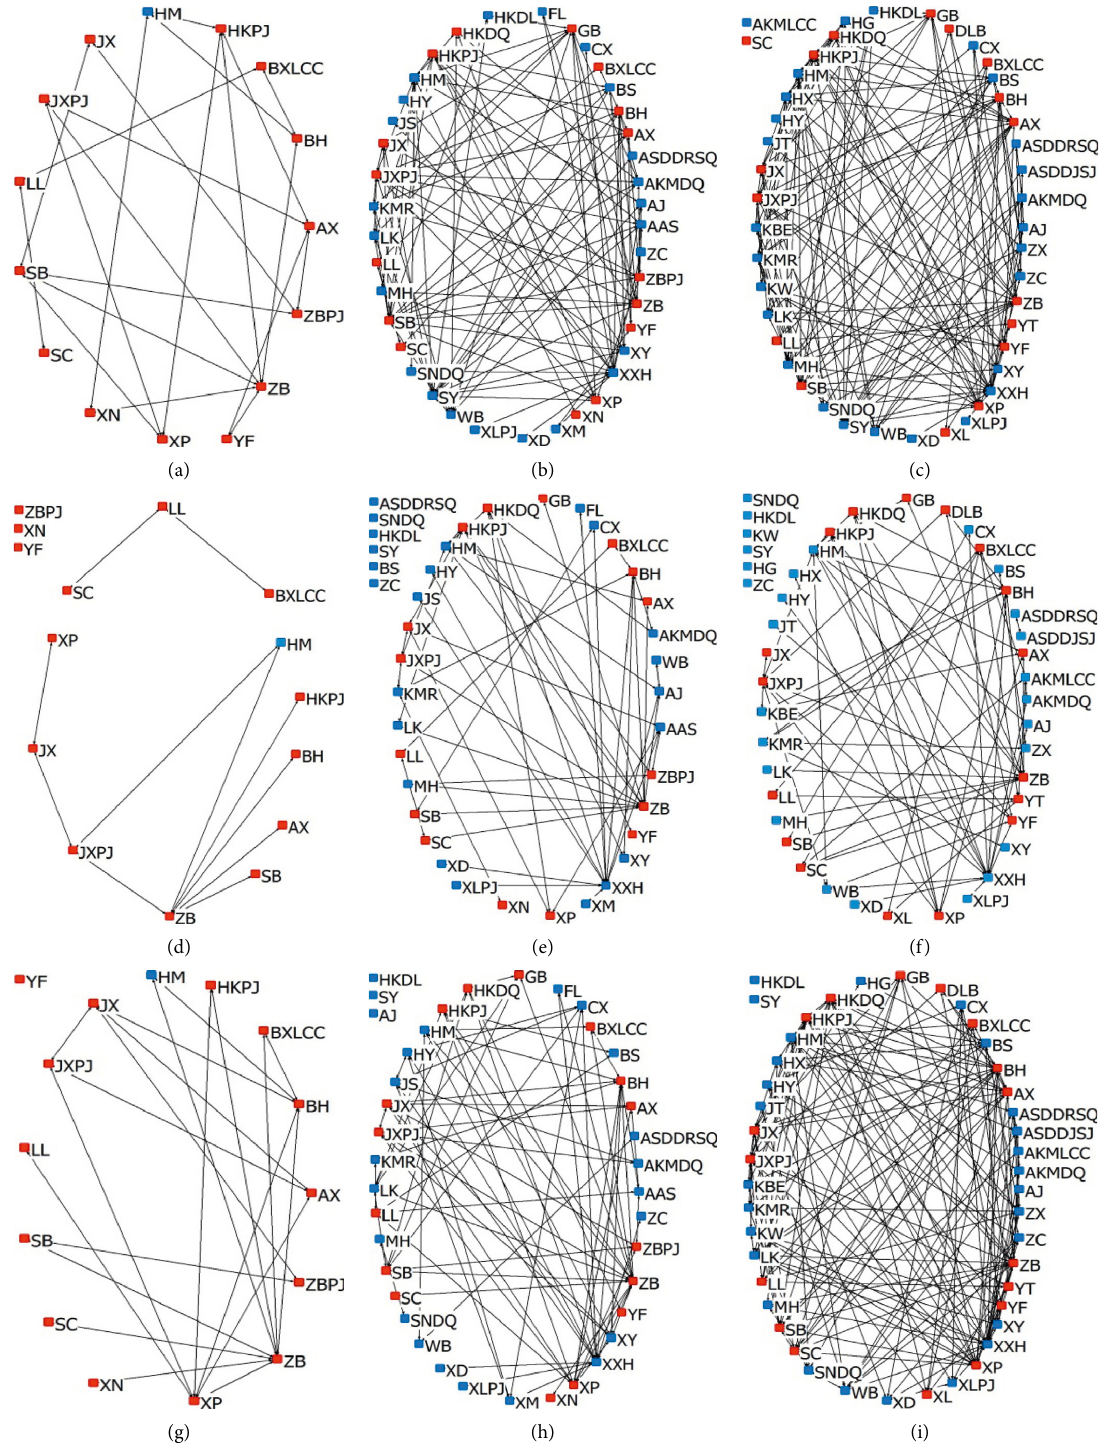
Figure 2: Relationship network of refrigeration firms in Minquan county. (a) Economic relation network in 2009. (b) Economic relation network in 2013. (c) Economic relation network in 2017. (d) Technical cooperation network in 2009. (e) Technical cooperation network in 2013. (f) Technical cooperation network in 2017. (g) Social communication network in 2009. (h) Social communication network in 2013. (i) Social communication network in